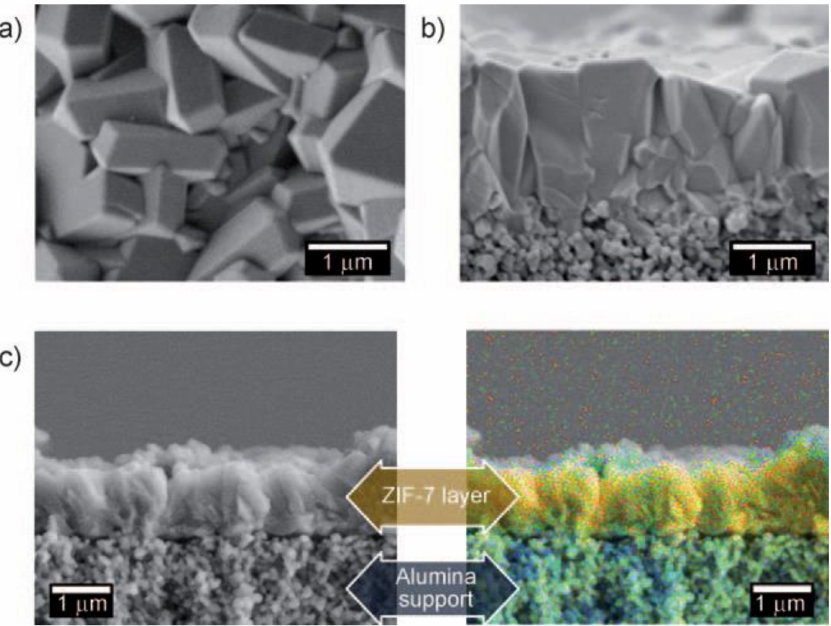
Figure 13. ( a ) Top view SEM images, ( b ) cross-section SEM image, and ( c ) EDXS mapping (orange Zn, cyan Al) of ZIF-7 membrane prepared on alumina support [128].